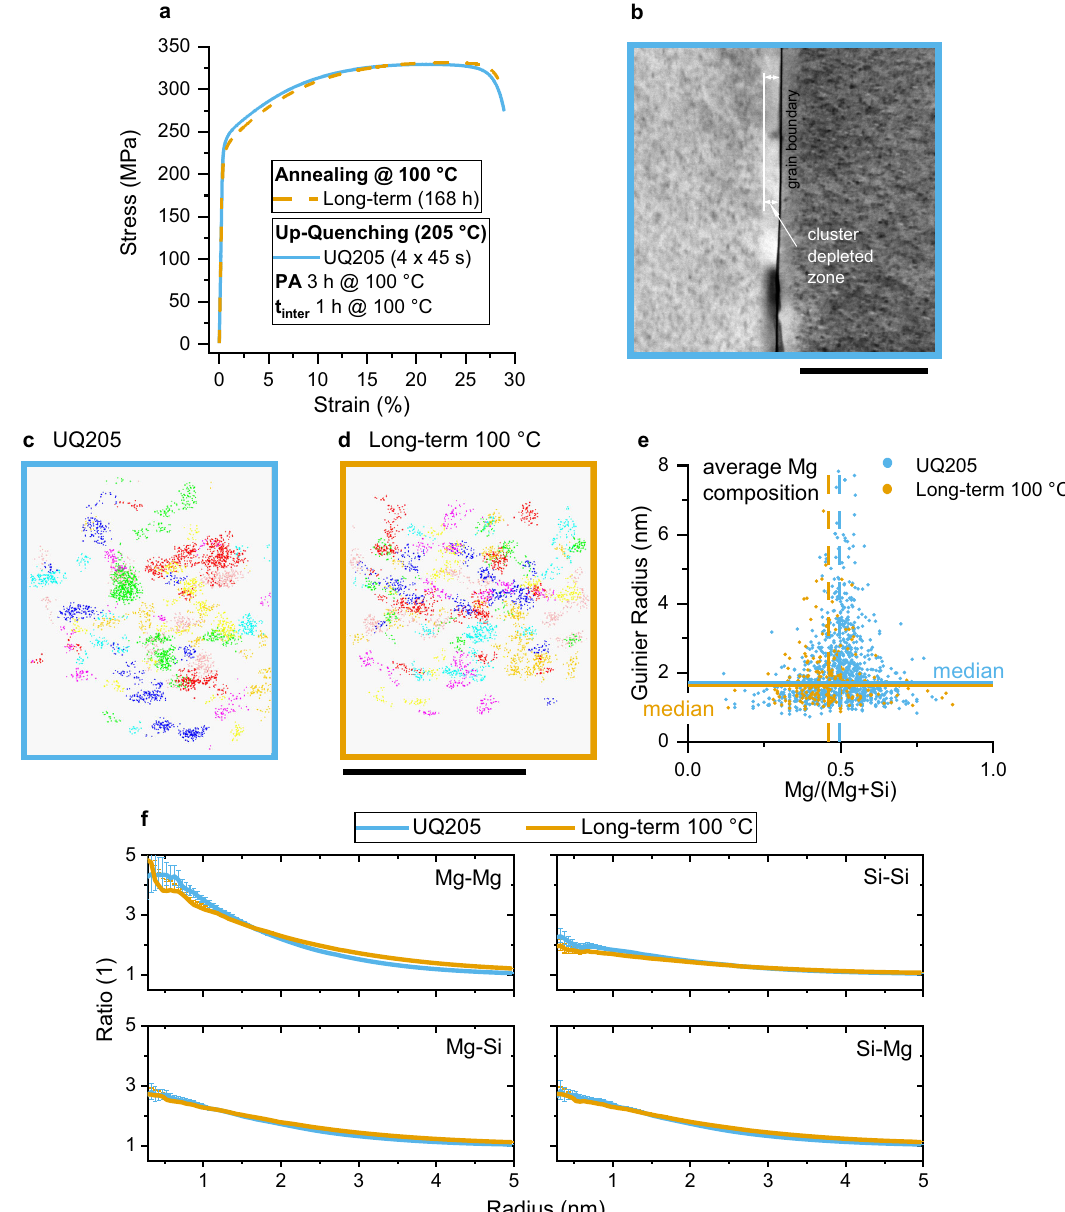
Fig. 7 Stress – strain curves resulting from up-quenching strategy UQ205 plus long-term annealing and corresponding microstructure. a Stress – strain diagram. b LAADF-STEM micrograph of a representative grain boundary for UQ205 (the scale bar corresponds to 150 nm). c , d Depiction of all solutes that are incorporated into clusters in an equally large cylinder cut from the whole sample volume for UQ205 ( c ) and for long-term annealing ( d ) measured via APT (the scale bar corresponds to 30 nm for ( c ) and ( d )). e Size of clusters (Guinier radius) in relation to the Mg-content of each cluster from APT. f Spatial position analysis of solute atoms from APT. Up-quenching at adequate temperate (205 °C) accelerates cluster hardening and, within 7 h, generates mechanical properties and microstructure comparable to those produced by long-term annealing at 100 °C for 168 h. “ PA ” stands for pre- annealing. Error bar boundaries are calculated using the mean value of the randomized radial distribution function and its standard deviation (for further information please see ref. 35